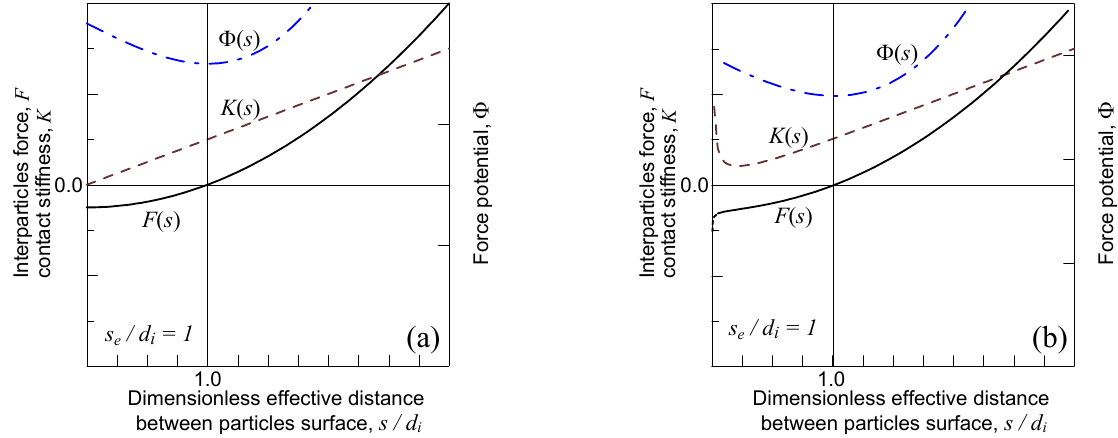
Figure 3: Force potential and corresponding forces and stiffness according to the linear elastic behaviour for an equilibrium distance / 1 s d  , (a) without and (b) with the no-penetration e i